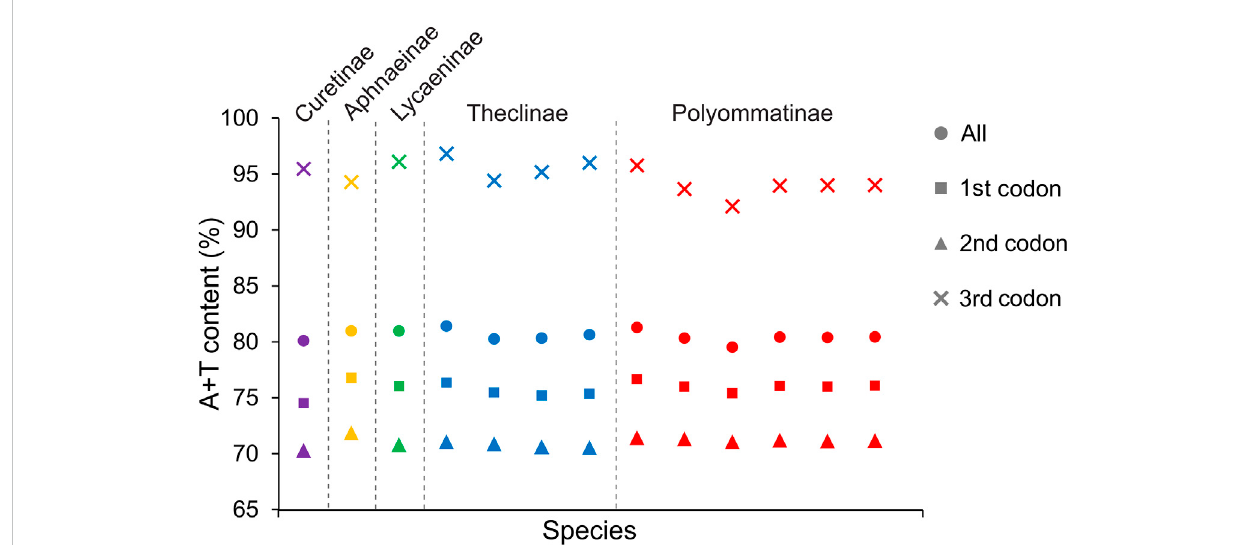
FIGURE 4 A + T contents of mitochondrial protein-coding genes among fi ve subfamilies within Lycaenidae.